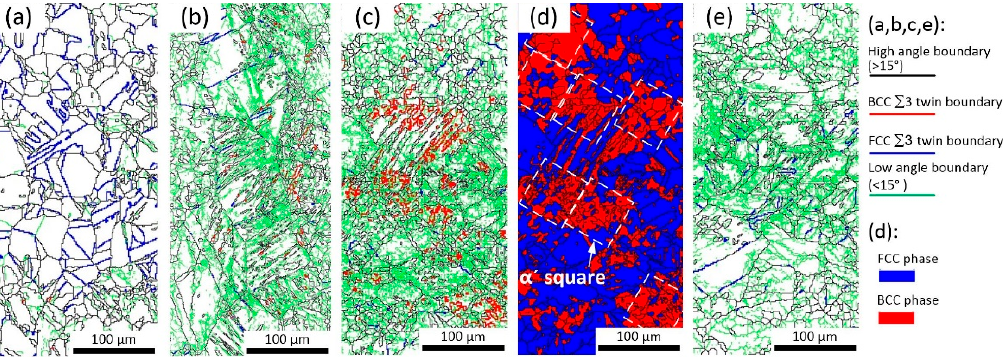
Figure 4. EBSD results of un ‐ prestrained ( a ), 20 °C 10% ( b ), 20 °C 30% ( c , d ), and 80 °C 30% ( e ) prestrained 304L steels. Blue lines in (a) are annealing twin boundaries, which become fragmented in (b,c) due to deformation (bule or red lines). (c) contains more fragmented red lines than (b) indicating the formation of deformation twins. (d) shows that α′ platelets can be modeled as squares.